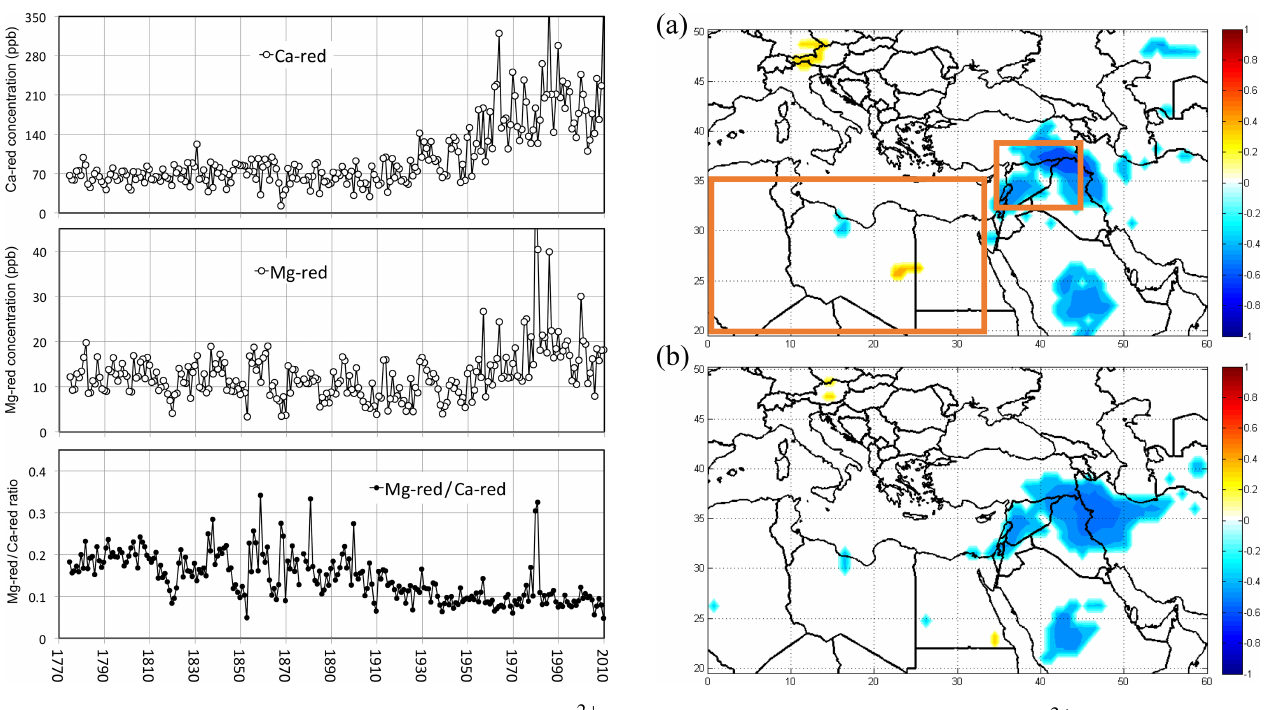
Figure 10. Spatial correlation of Elbrus Ca 2 + concentrations with soil moisture (a) , and precipitation (b) ERA-Interim from 1979 to 2013. North African and Middle Eastern domains are shown by or- ange